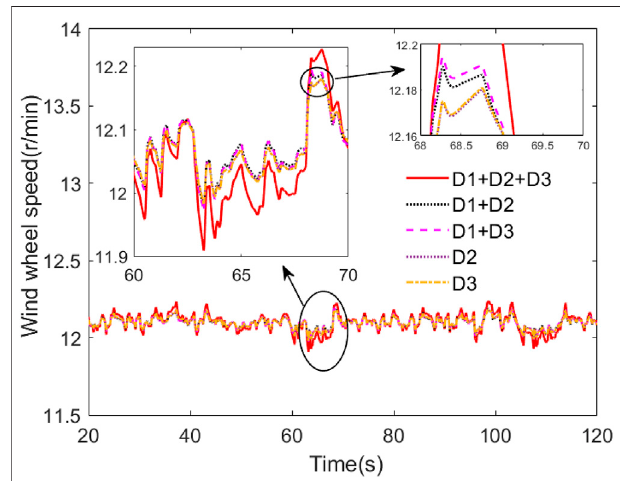
FIGURE 16 | Comparison curves of wind turbine output power under turbulent wind.